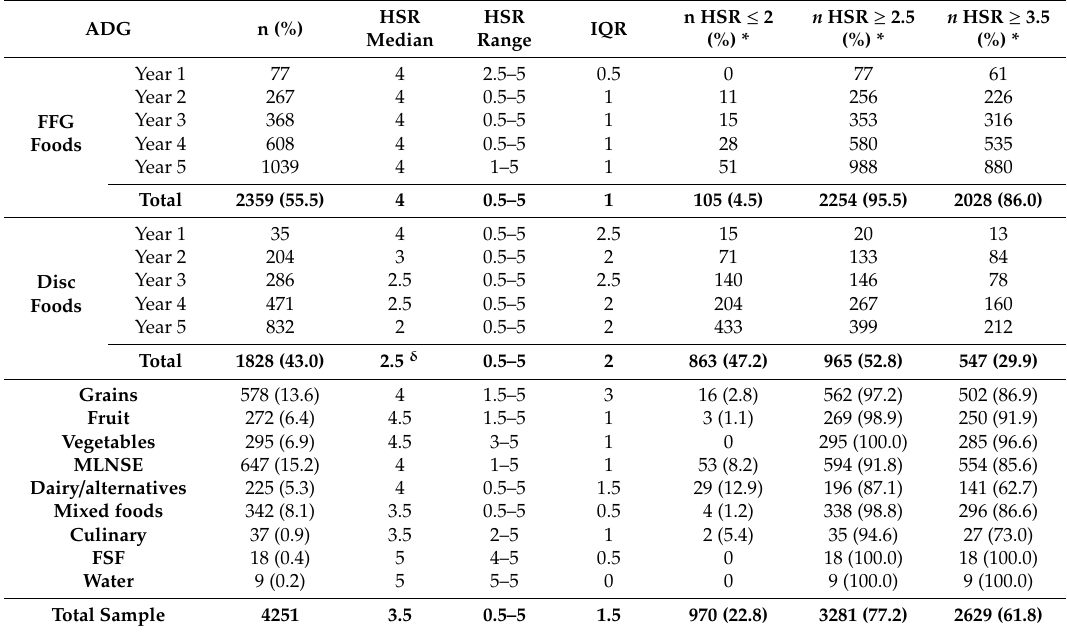
Table 3. Descriptive statistics of HSR by Australian Dietary Guidelines food category and implementation